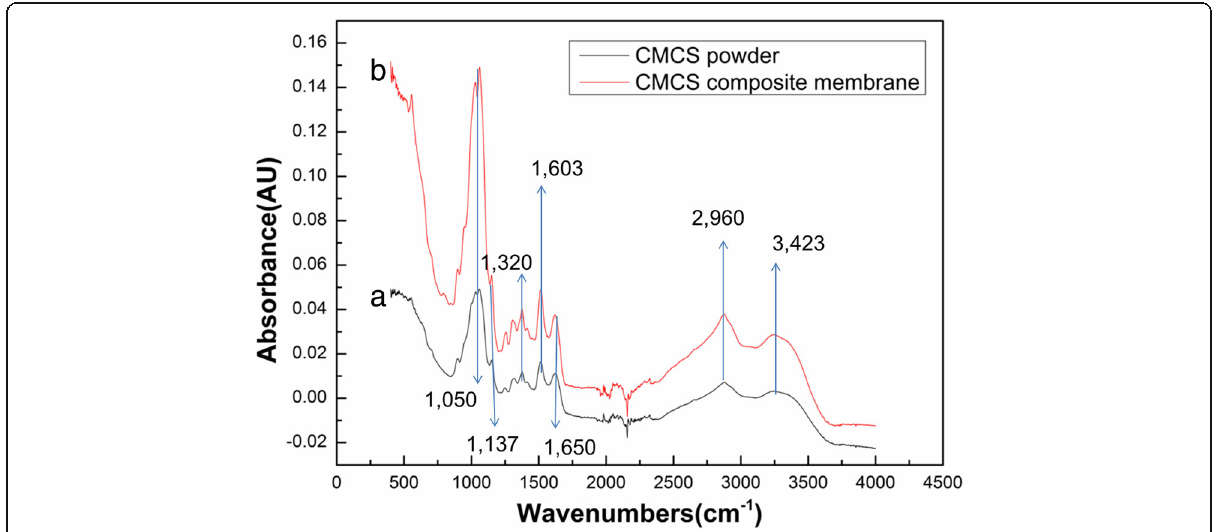
Fig. 4 FTIR spectra of the a electrospun CMCS powder and b electrospun CMCS/PEO composite nanofiber